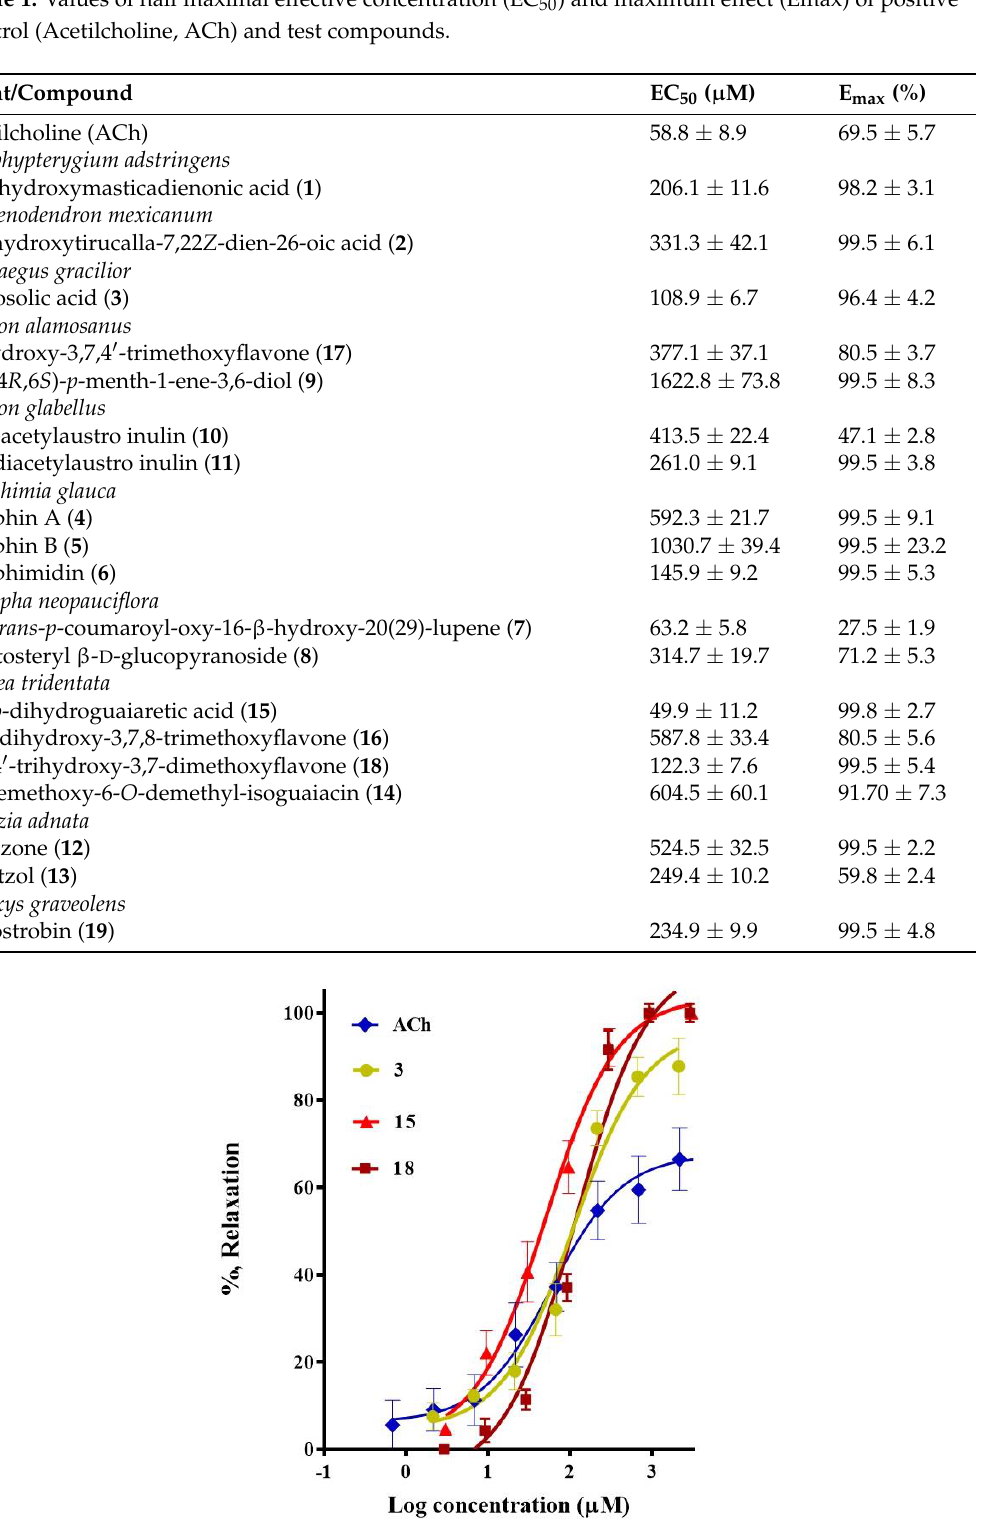
Figure 2. Concentration-response curves of the vasodilator effect of corosolic acid ( 3 ), meso - dihydroguaiaretic acid ( 15 ), and 5,8,4′-trihydroxy-3,7-dimethoxyflavone ( 18 ). Acetylcholine was used as a positive control.